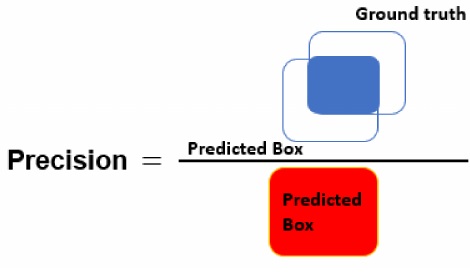
Figure 6. Pictorial representation of precision.